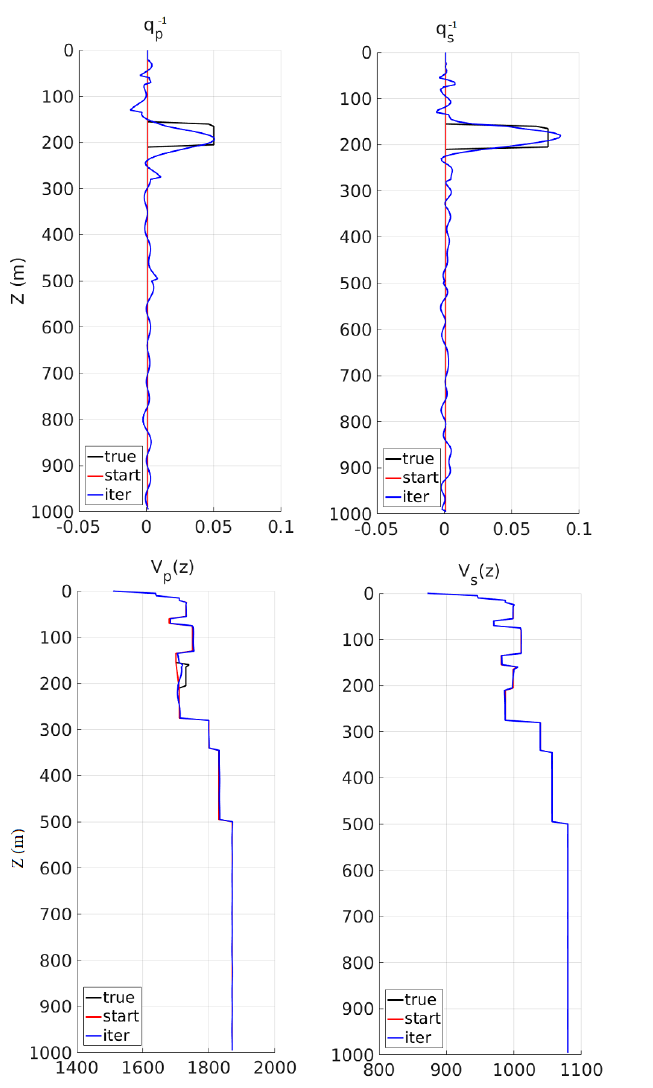
Figure 7. The parameters of a viscoelastic medium recovered by multi-parameter